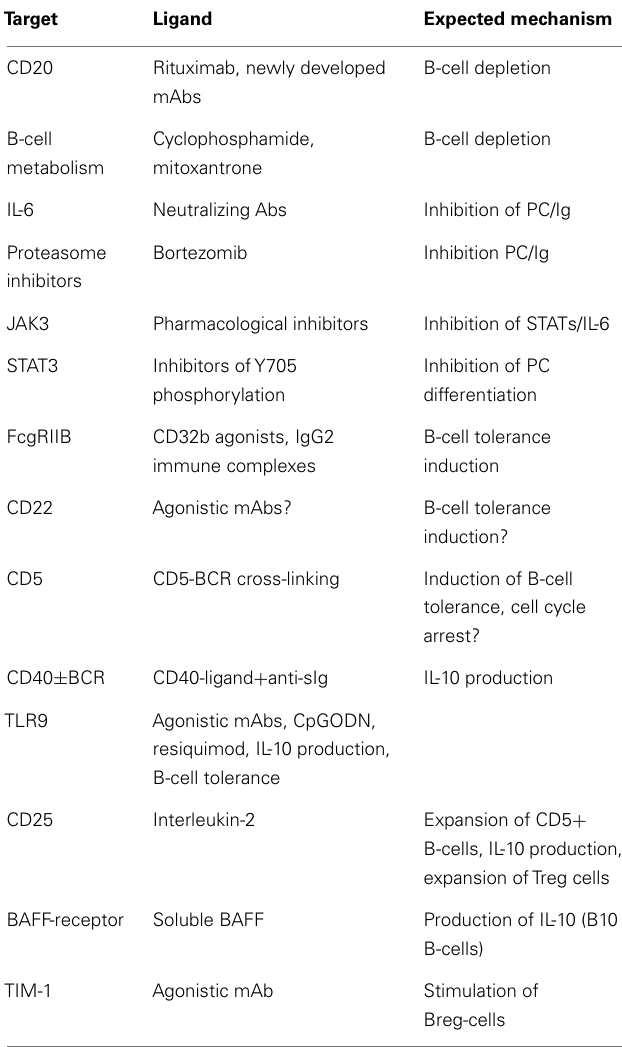
Table 1 | Potential B-cell targets for the treatment of allograft